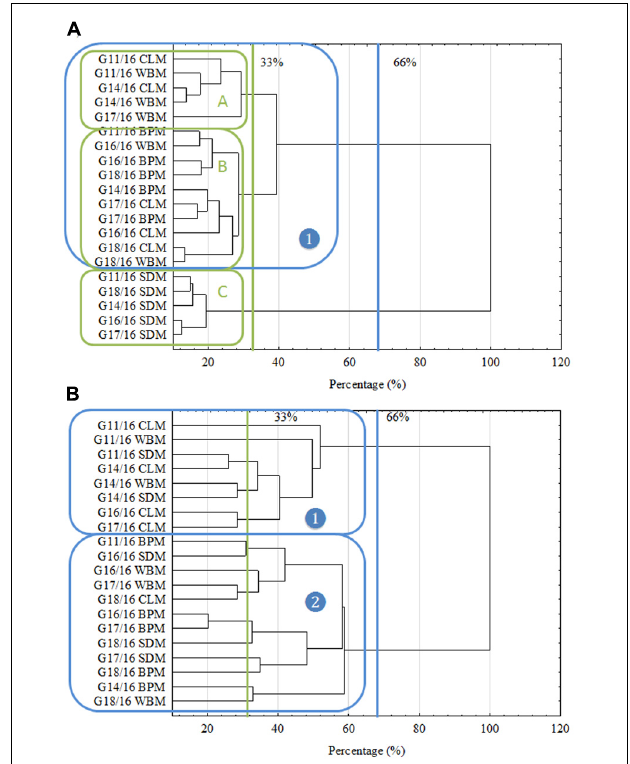
FIGURE 5 | Intraspecific genetic fingerprinting of P. setifera isolates as influenced by preculturing. (A) Genome-derived fragments clustering, (B) transcriptome-derived fragments clustering based on Amplified Fragment-Length Polymorphism analysis. For explanations: please see Figure 1